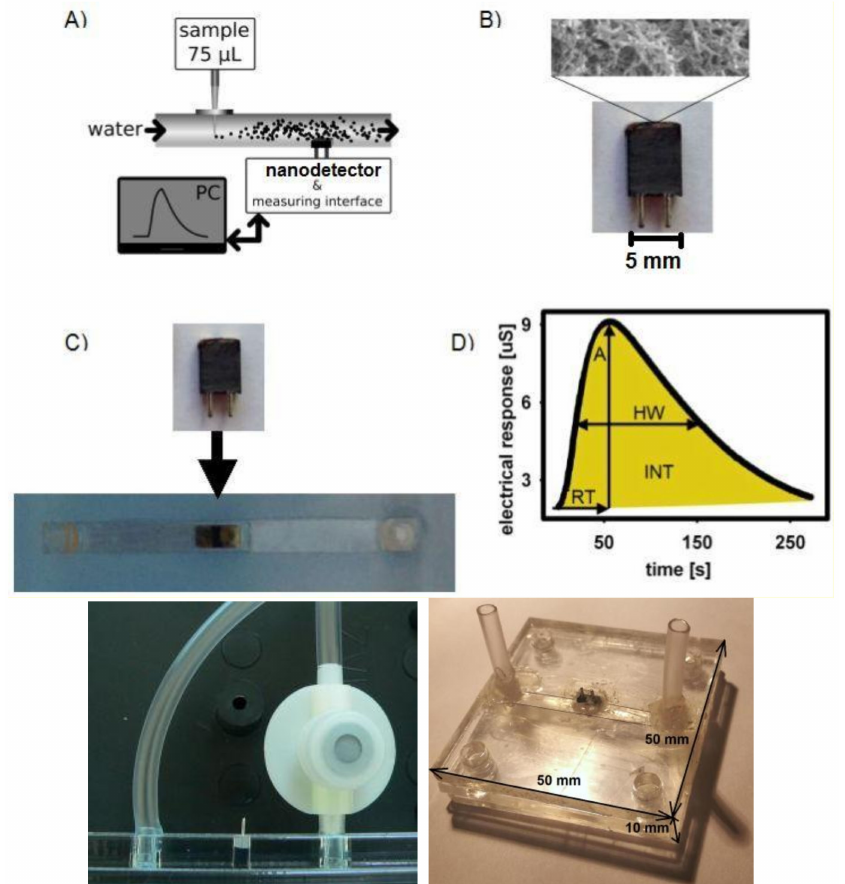
Figure 4. A scheme of the device’s operation in its current version (with the cylindrical flow channel) ( A ); the details of the nanodetector used ( B ); the micro fluidic system with a cuboids channel ( C ) for practical application and implementation ( below )—designed analogously to that used previously [31,32]; the measured parameters of the signal ( D ): A—the amplitude, RT—the retention time, HW—the half-width, INT—the integral